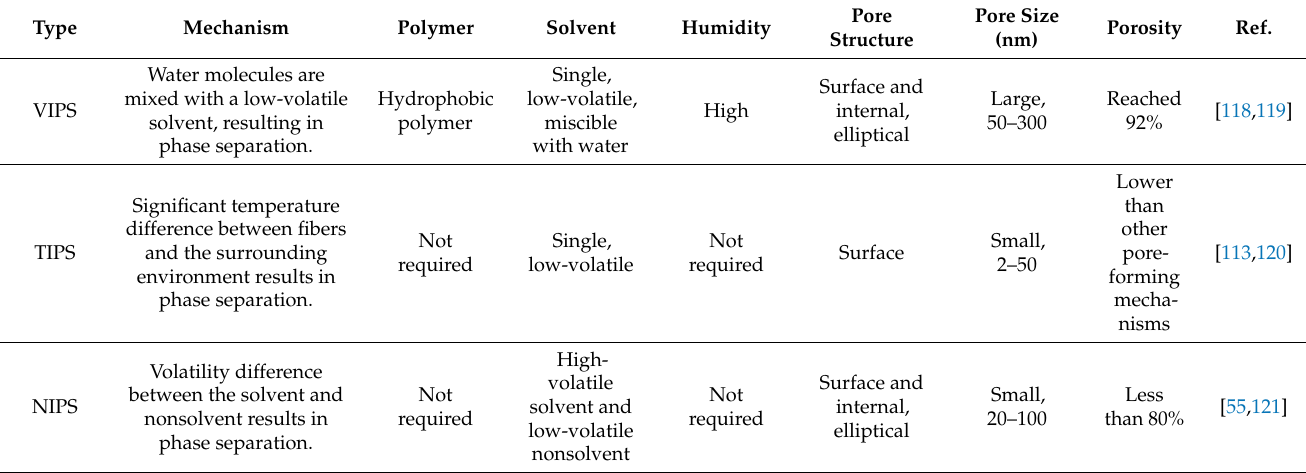
Table 1. Comparison of different phase separation mechanisms, formation conditions, and